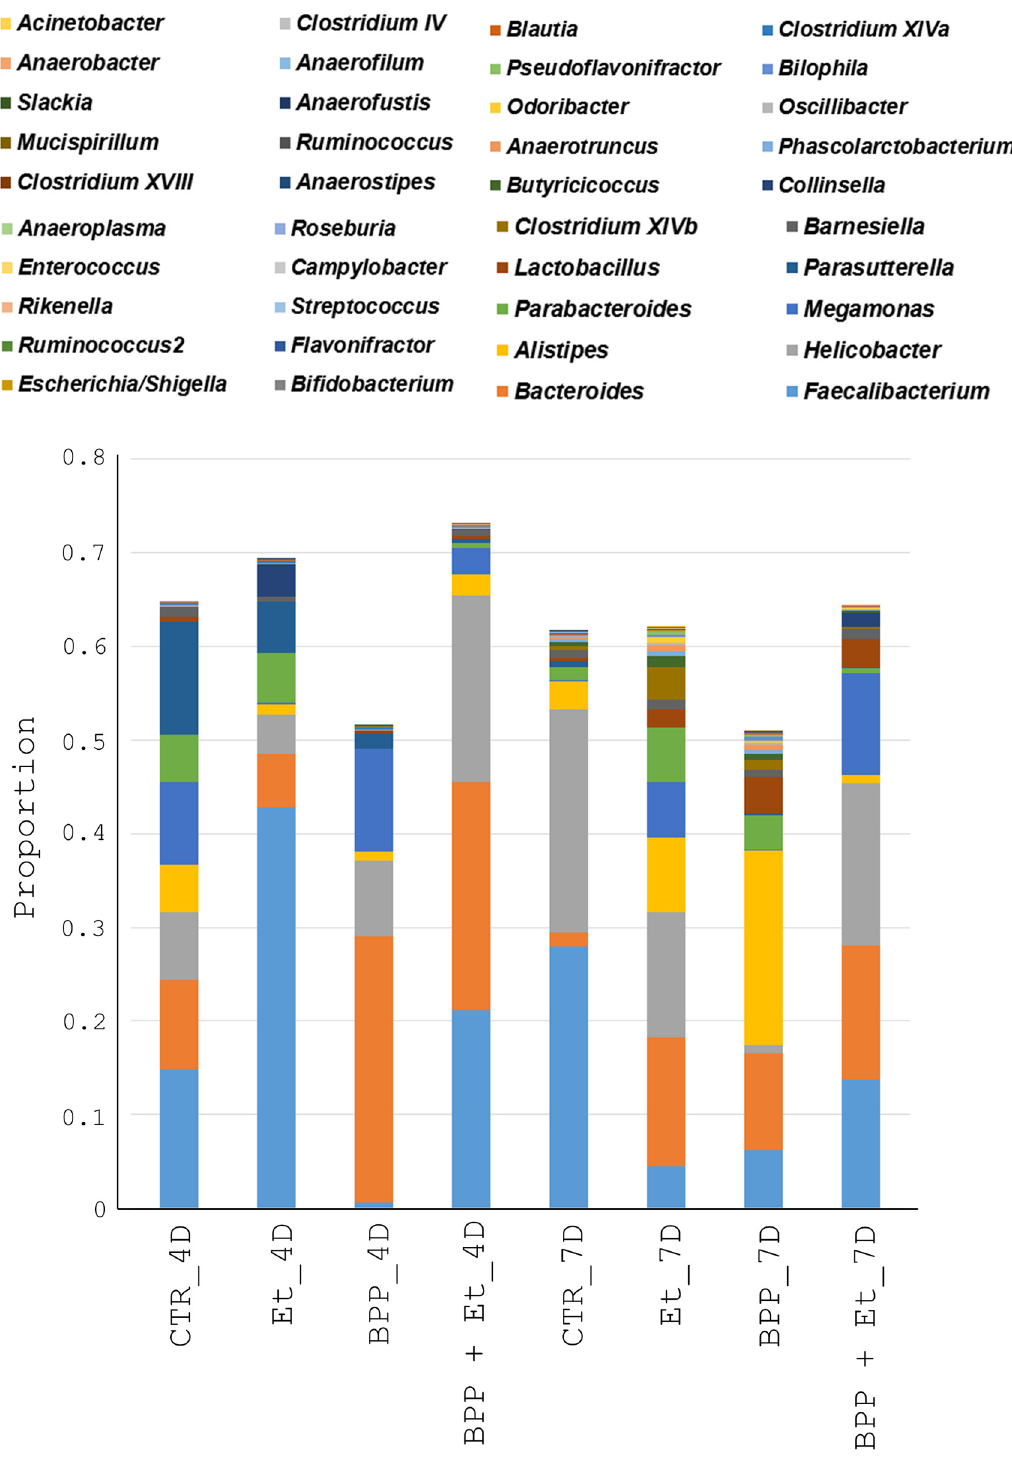
Fig 4. Proportion of the bacterial community compositions at the genus level in the guts of chickens. Proportion of the bacterial genera in the guts of chickens ( Fig 2) was determined.